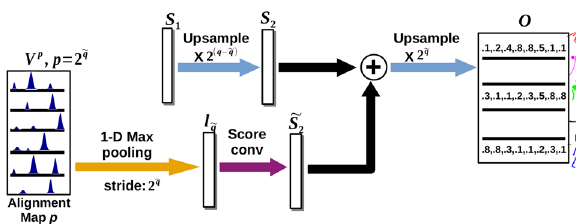
Fig. 6 Fine-prediction module of DACNN. The skip-connections from score maps of specific Abs-filters result in fine-grained seg- mentations compared to Fig. 5. The alignment map 𝐕 p in the block- diagram corresponds to the largest Abs-filters of size p = 2 ̃ q s.t. ̃ q ≥ 2